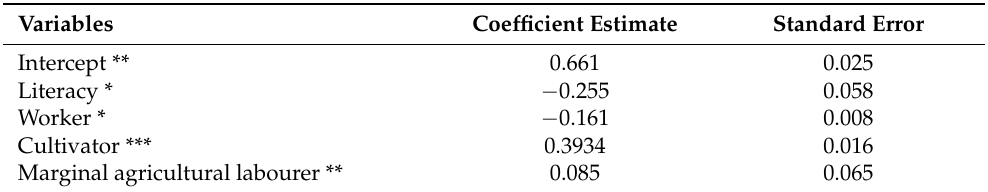
Table 1. Demographic variables that are significantly associated with HEC occurrence,